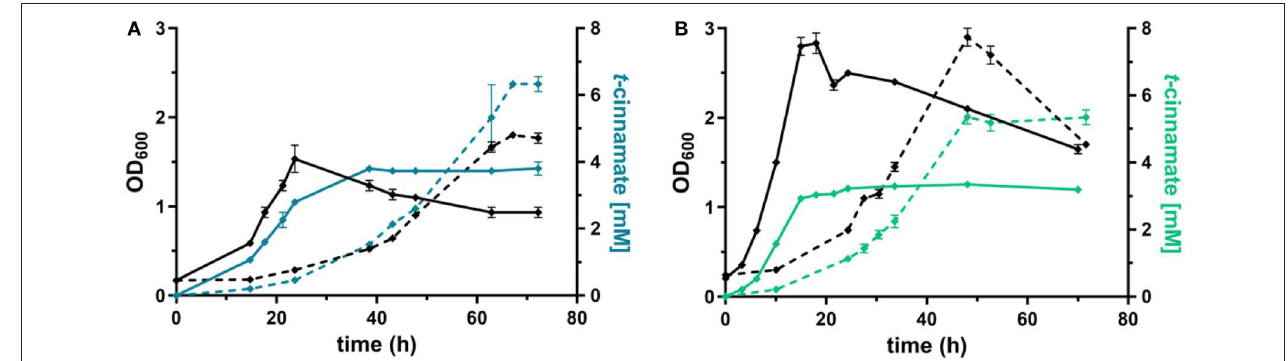
FIGURE 4 | Shake flask cultivations of P. taiwanensis GRC3 1 8 1 pykA -tap with varying heterologous expression modules. (A) Growth (black lines) and t-cinnamate production (blue lines) by P. taiwanensis GRC3 1 8 1 pykA -tap attTn7 :: P 14 g AtPAL- aroG fbr -pheA T 310 in MSM containing 20mM glucose (solid line) or 40mM of glycerol (dotted line). (B) Growth (black lines) and t -cinnamate production (green lines) by P. taiwanensis GRC3 1 8 1 pykA -tap attTn7 :: P 14 f AtPAL in MSM containing 20mM glucose (solid line) or 40mM of glycerol (dotted line). Error bars represent the standard error of the mean ( n =